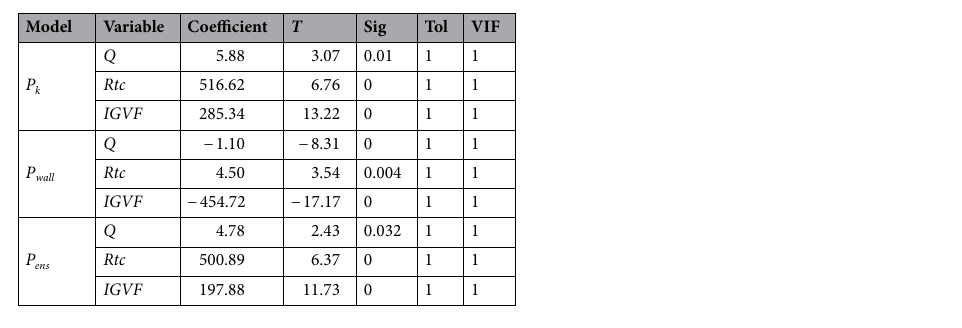
Table 9. Correlation test between